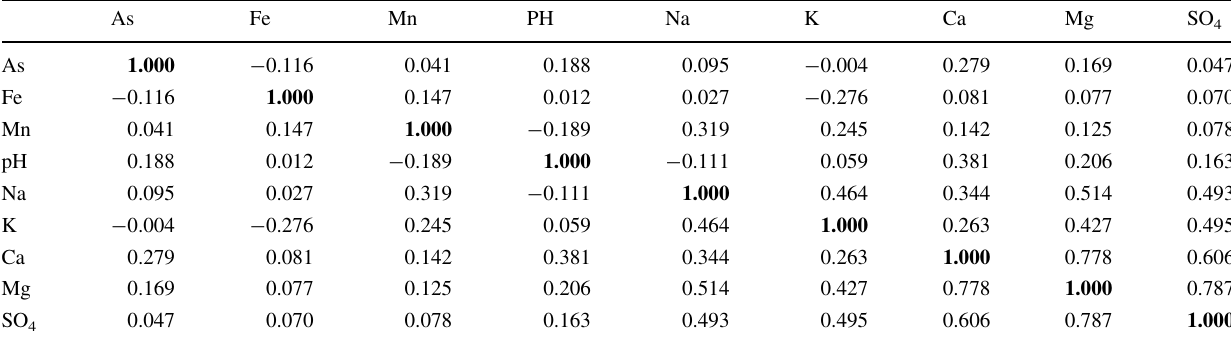
Bold values are used to make a clear visibilty between the correlated variables